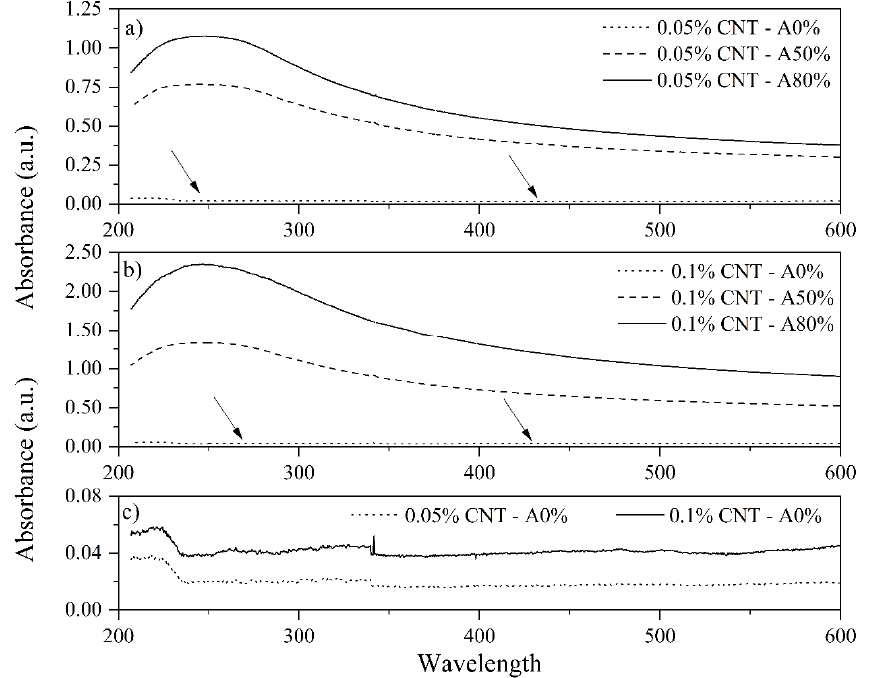
Figure 3. Influence of ultrasonication amplitude on UV-Vis absorption spectra of ( a ) 0.05% CNT; ( b ) 0.1% CNT dispersions and ( c ) amplification of 0.05% CNT—A0% and 0.1% CNT—A0%.